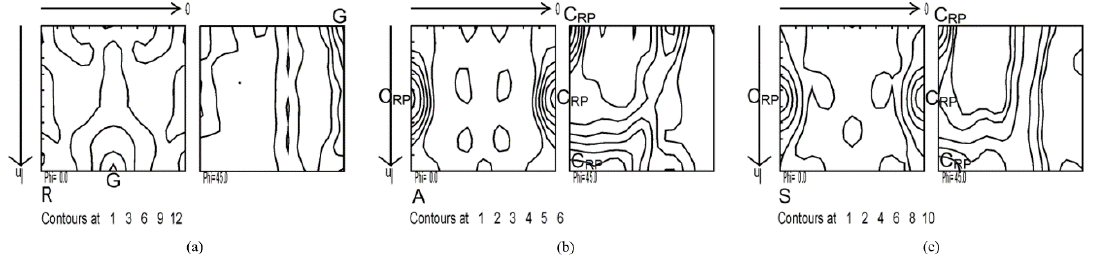
Figure 1. ODFs of (a) hot rolled sample as received, (b) asymmetrical and (c) symmetrical samples after intermediate annealing.